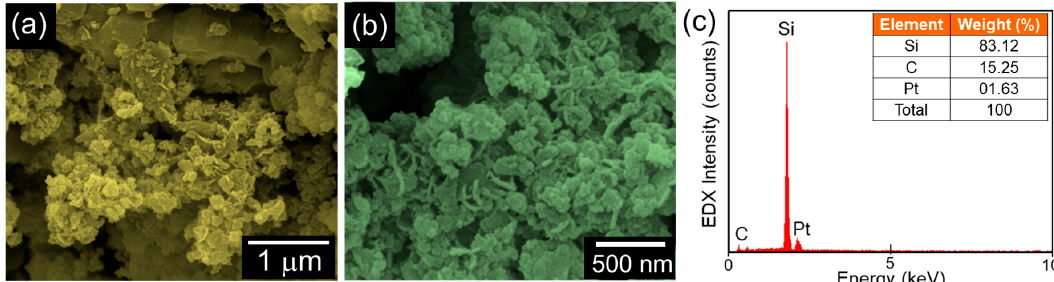
Figure 3. ( a ) Low-magnification FE-SEM image, ( b ) High-magnification FE-SEM image, and ( c ) EDX spectrum of the C-Si nanocomposites. The inset of ( c ) summarizes the compositional properties of the C-Si nanocomposites.